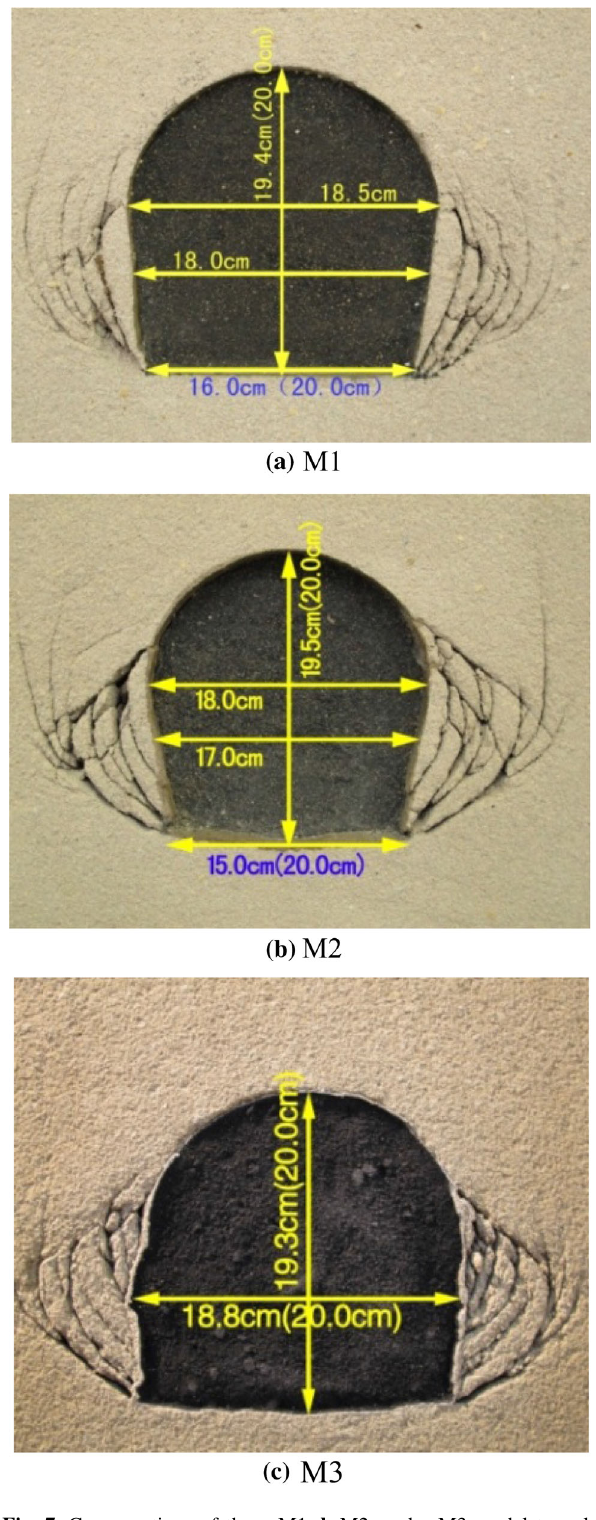
Fig. 7 Cross sections of the a M1, b M2, and c M3 model tunnels after